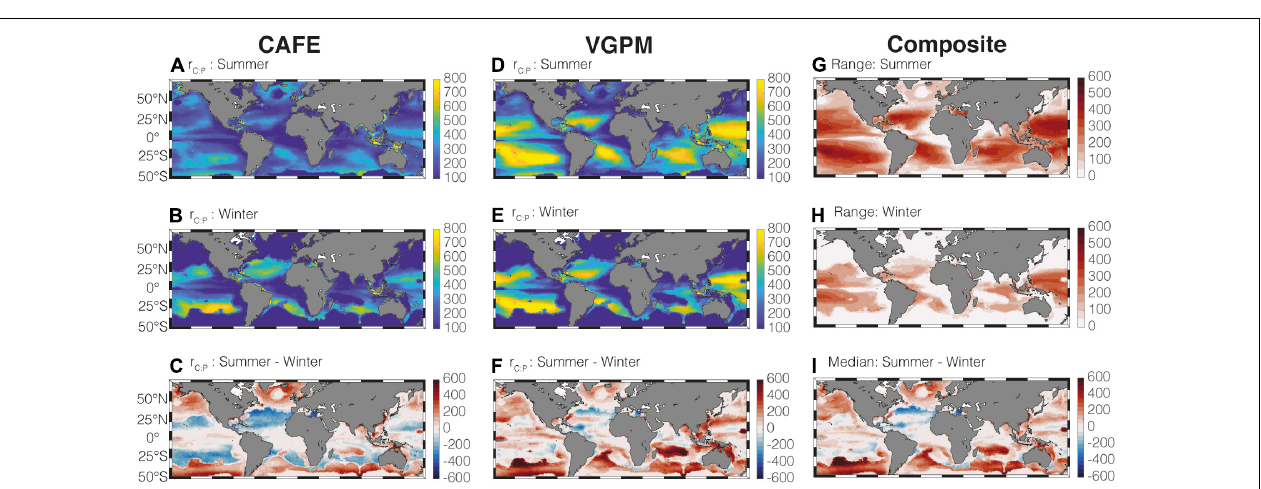
FIGURE 2 | Geographical locations of suspended POM sample stations used in this study. Red dots represent samples collected in summer months (July–September in the Northern Hemisphere, January–March in the Southern Hemisphere), and blue dots represent samples collected in winter months (January–March in the Northern Hemisphere, July–September in the Southern Hemisphere). Dashed boxes delineate regions where the seasonality of satellite-informed estimate is examined (NAT, North Atlantic Temperate; NASG, North Atlantic Subtropical Gyre; SPSG, South Pacific Subtropical Gyre; EQU, Equatorial Upwelling regions).